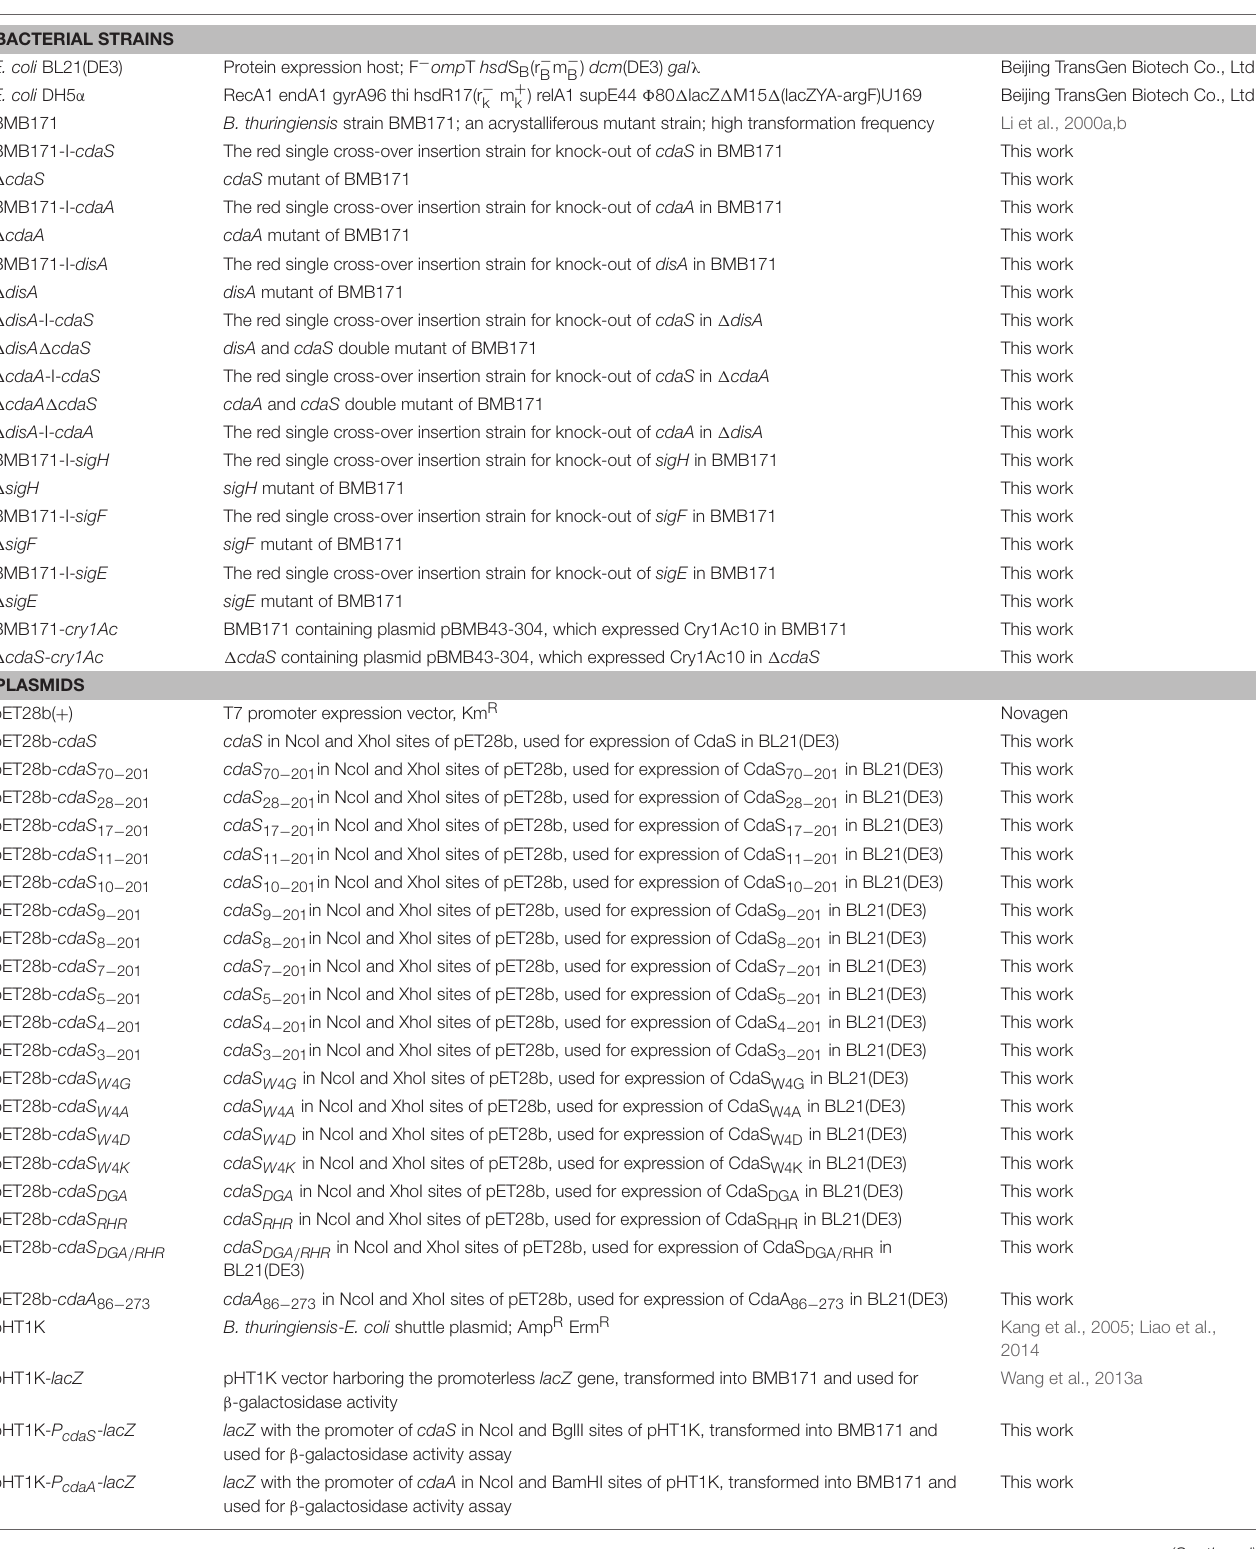
TABLE 1 | Bacterial strains and plasmids used in this study. Bacteria or